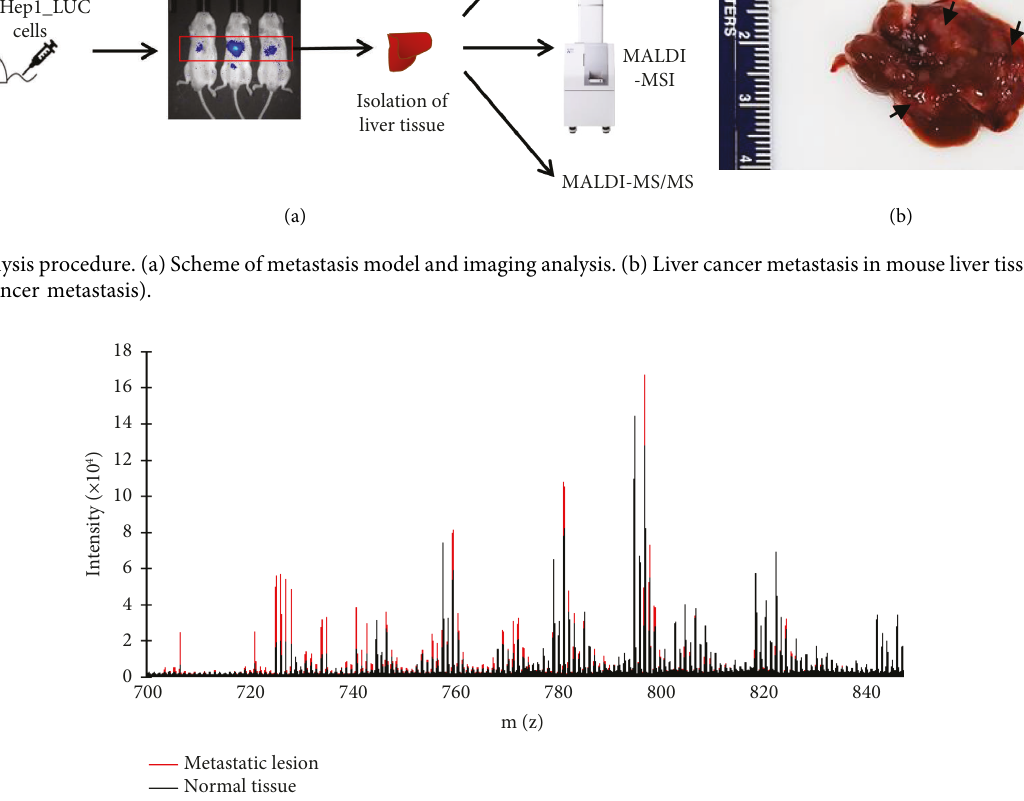
Figure 2: Comparison of intensity between the metastatic lesion and normal tissues. The spectrum of molecular species in the m/z 700 ～ 850 range. Four slides of each sample were determined by MALDI-MS. Five spots per slide were selected. Table 1: Intensity of mass to charge ratio (m/z) in the metastatic lesion and normal